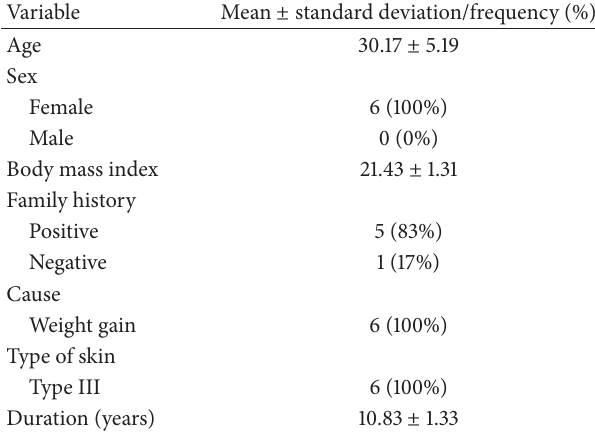
Table 1: Patients’ characteristics.